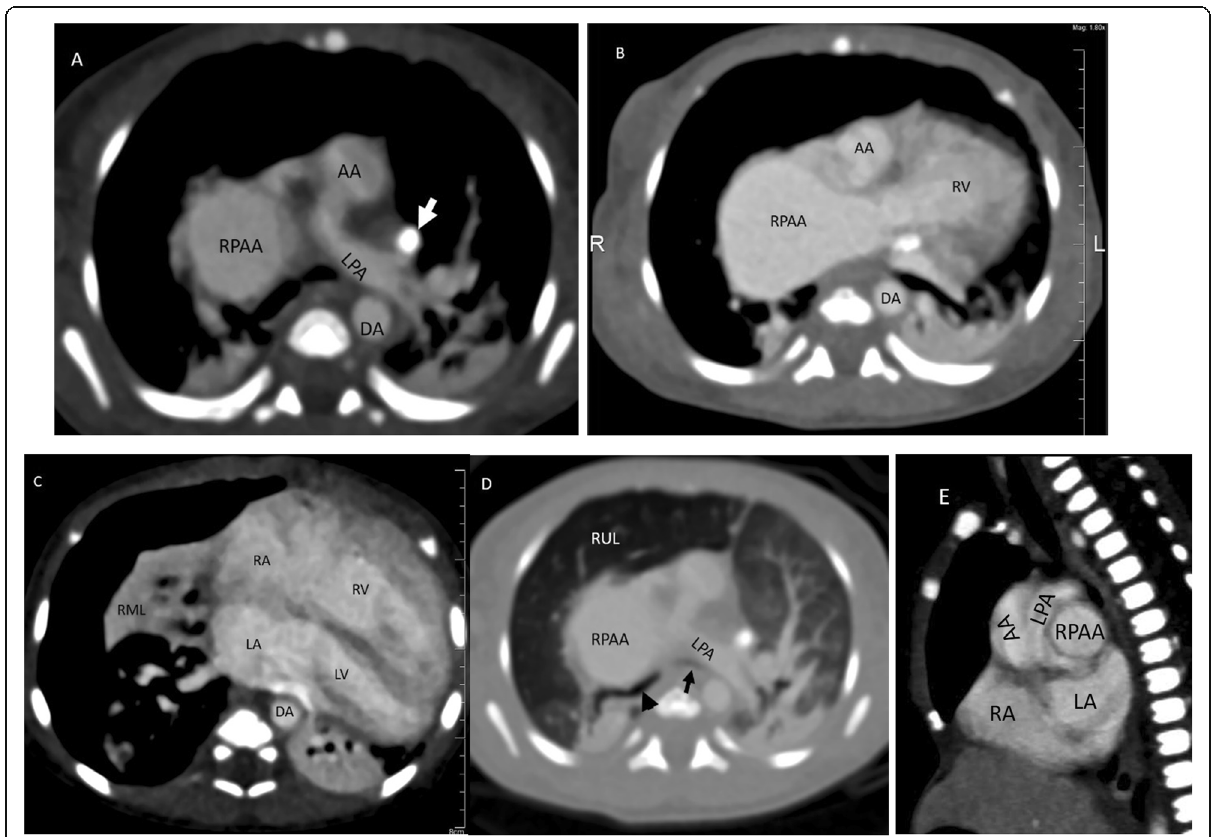
Fig. 7 A 5-week-old baby with pulmonary artery aneurysm detected on echocardiography. a Axial CT shows the left pulmonary artery (LPA) arises from ascending aorta (AA) and marked aneurysmal dilatation of the right pulmonary artery (RPAA), left SVC noted (arrow). b The right ventricle (RV) gives off the right pulmonary artery (RPA) which shows aneurysmal dilatation (RPAA). c The four cardiac chambers illustrated along with right middle lobe (RML) collapse. d Airway and lung changes: the left (arrow) and right (arrowhead) main bronchi are compressed by the aberrant LPA and RPAA respectively. Due to RML collapse, there was compensatory hyperinflation of the right upper lobe that crossed the midline and herniated into the left side. e 2D Sagittal reformat image shows the origin of LPA from AA; both structures seen anterior to the